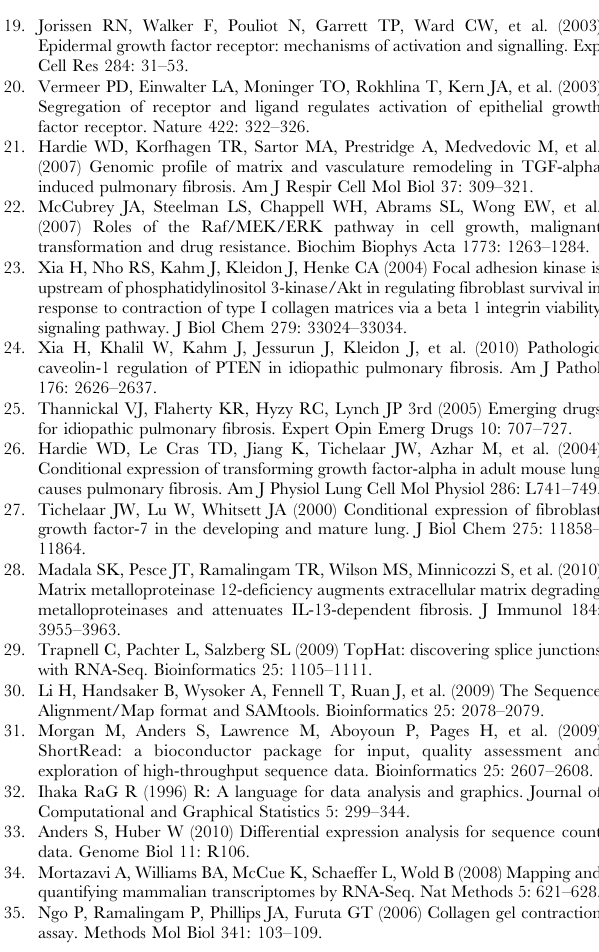
Figure S1 Combined inhibition of MEK and PI3K pathway inhibitors had no severe toxic effects on kidney (creatinine) and liver (serum ALT) functions during TGF a -induced fibrosis.